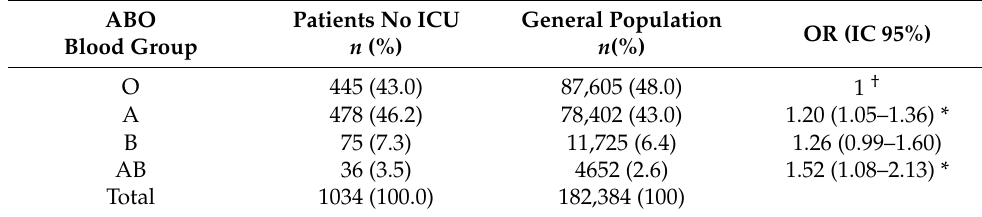
Table 2. Comparison between ABO group distribution in the group of patients with